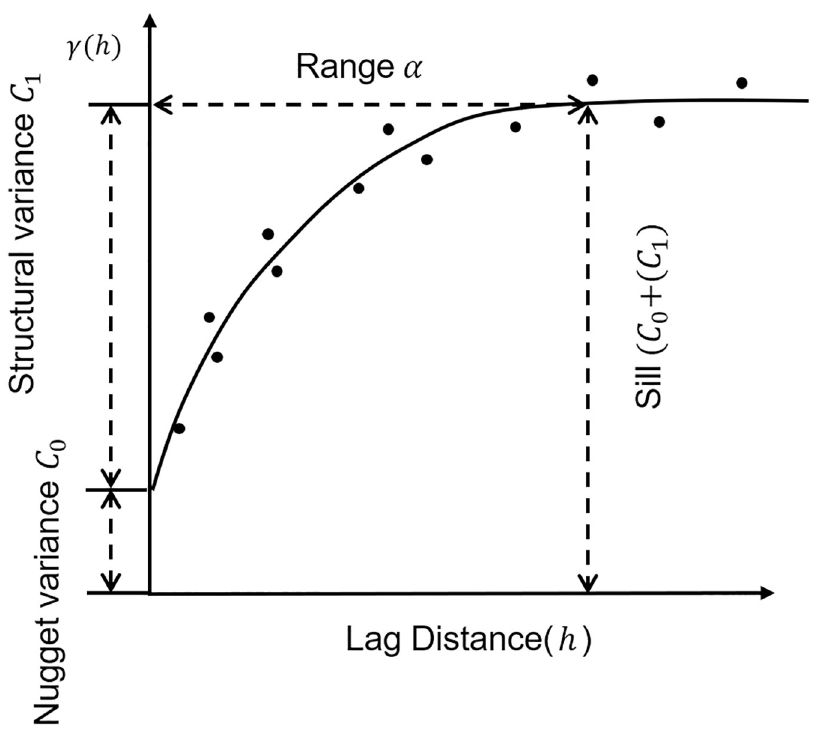
Fig 1. A diagram of the semi-variogram with three key parameters: The nugget variance ( c 0 ), the sill ( c 0 + c 1 ), and the range of spatial autocorrelation ( α ).